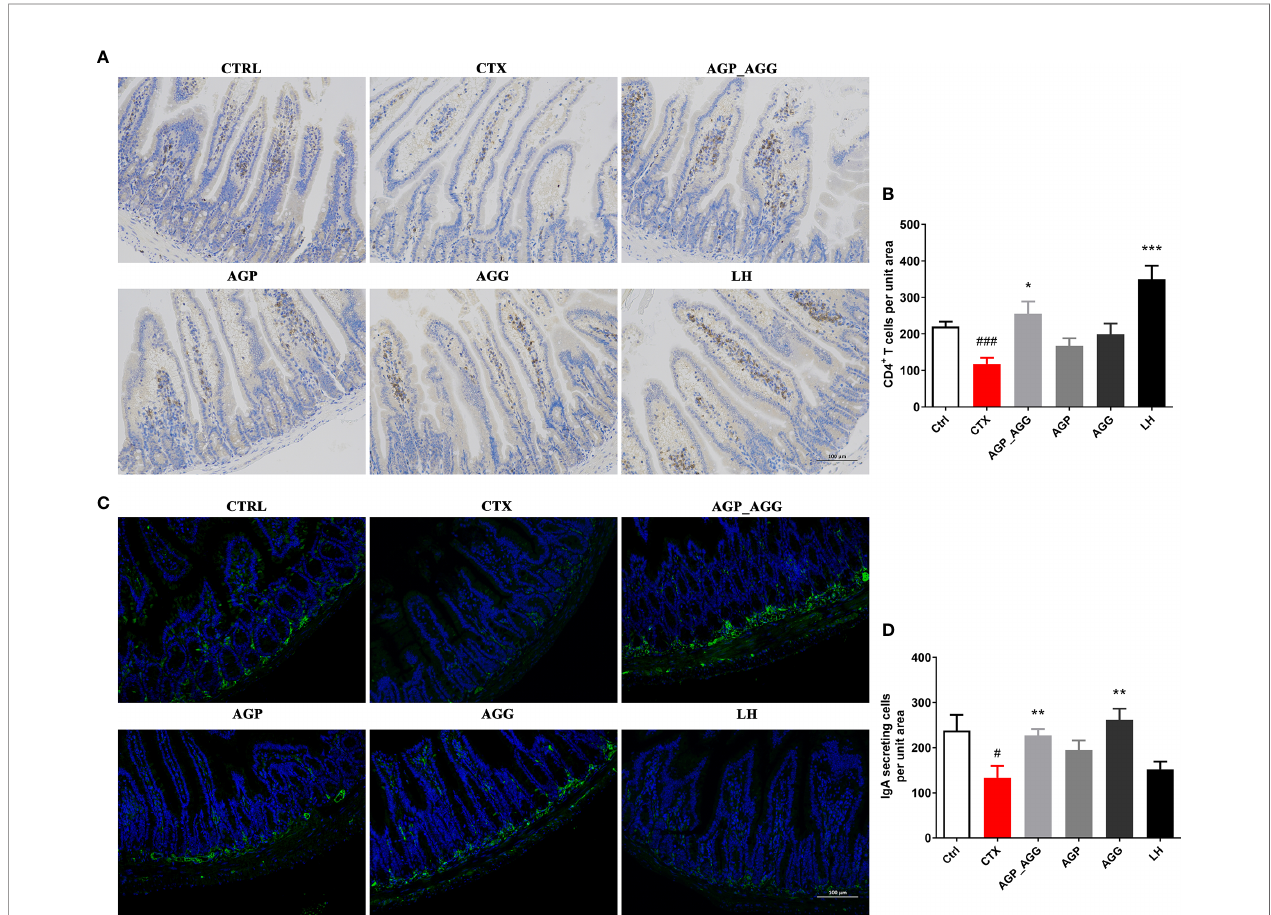
FIGURE 3 | AG treatments relived intestinal immune disorder in CTX-induced immunosuppression mice. (n=5 for each group). (A, B) Immunohistochemical staining with CD4 + of jejunum section (200 ×, Scale bar = 100 m m). (C, D) Immuno fl uorescence staining with IgA + and DAPI of jejunum section (200 ×, Scale bar = 100 m m). Data are expressed as mean with SD. # P < 0.05, ### P < 0.001 compared with Ctrl; * P < 0.05, ** P < 0.01, *** P < 0.001 compared with CTX by student t test. Ctrl, control group; CTX, cyclophosphamide-induced immunosuppressive group; AGP_AGG, American ginseng polysaccharide+American ginseng ginsenoside with cyclophosphamide-induced immunosuppressive group; AGP, American ginseng polysaccharide with cyclophosphamide-induced immunosuppressive group; AGG, American ginseng ginsenoside with cyclophosphamide-induced immunosuppressive